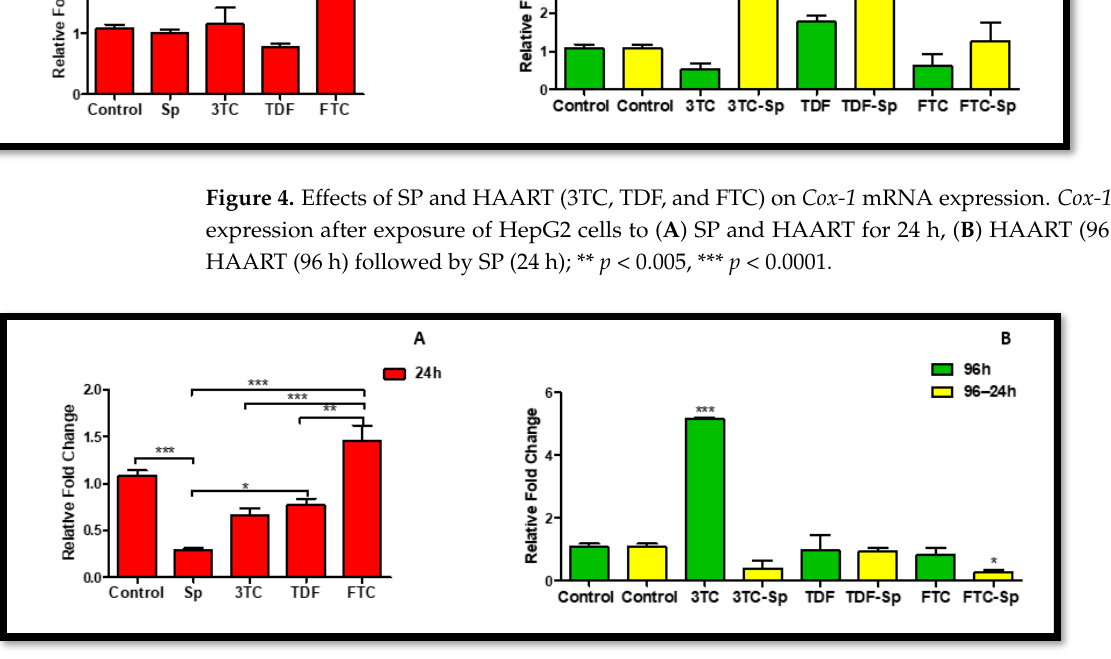
Figure 5. Effects of SP and HAART (3TC, TDF, and FTC) on Cox-2 mRNA expression. Cox-2 mRNA expression after exposure of HepG2 cells to ( A ) SP and HAART for 24 h, ( B ) HAART (96 h), and HAART (96 h) followed by SP (24 h); * p < 0.05, ** p < 0.005, *** p < 0.0001.